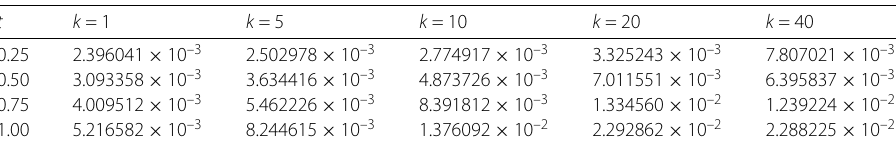
1 (cid:8) , τ = kh 1 ( h = 160 h